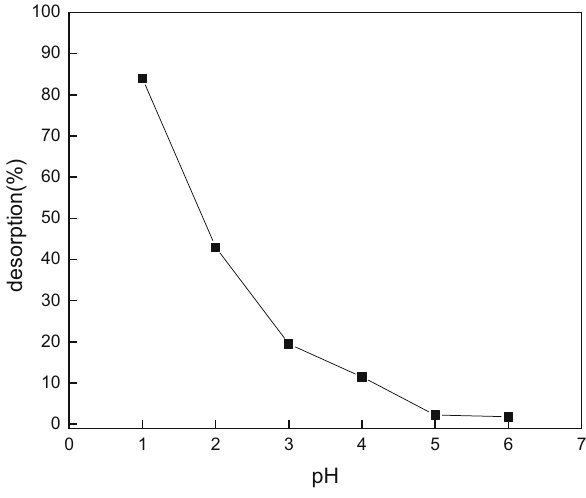
Figure 9: Desorption rate of Cu 2 + in hydrochloric acid solution at di ff erent pH.